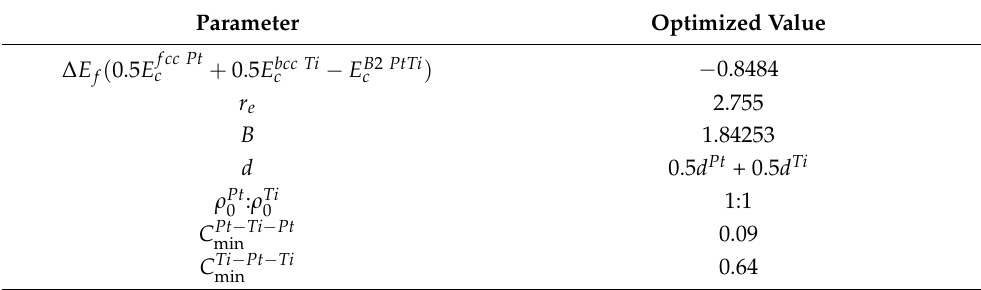
Table 2. Finalized 2NN MEAM interatomic potential parameter for the binary Pt–Ti system. The pa- rameters with units are the enthalpy of formation of the reference structure (B2 PtTi) ( ∆ E f , eV/atom), the equilibrium nearest-neighbor distance ( r e , Å), and the bulk modulus ( B , 10 12 dyne/cm 2 ). Detailed descriptions of the interatomic potential parameters for binary alloys can be found elsewhere